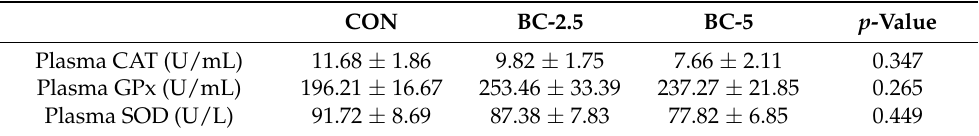
Table 4. Effect of increasing levels of bovine colostrum supplementation on plasma CAT, GPx and SOD enzymes (values are given as means ± SD).